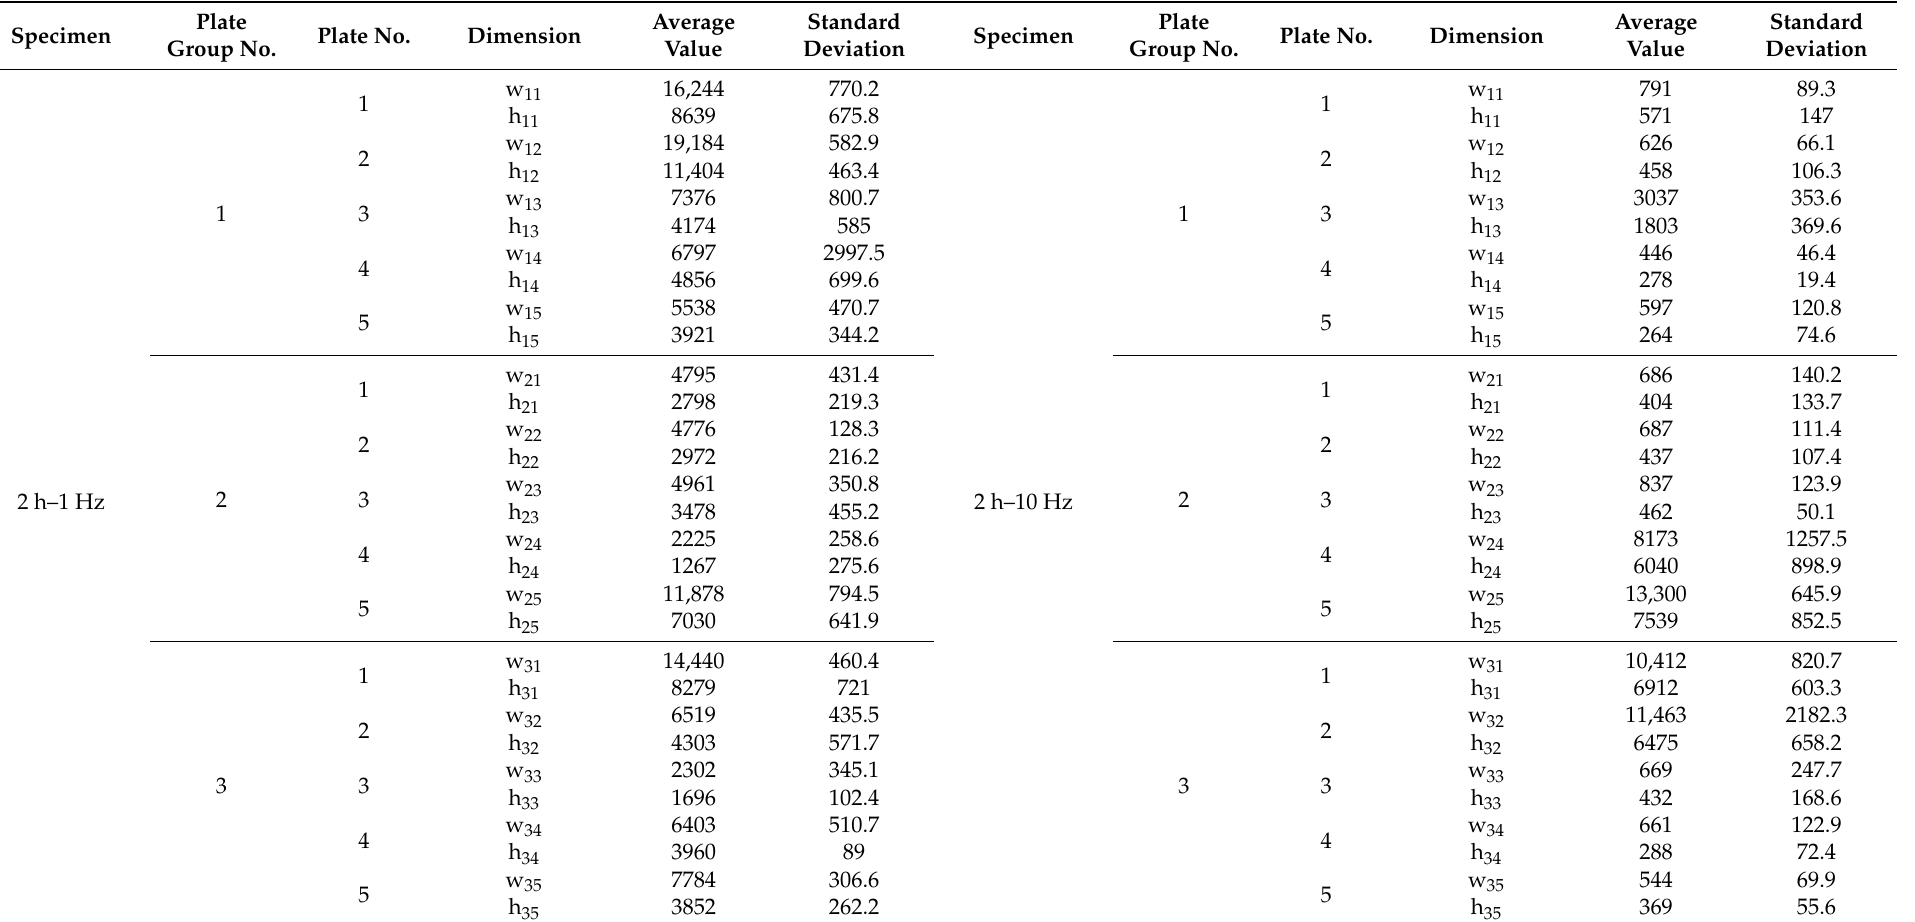
Table 1. Experimental values of martensite plate widths and heights